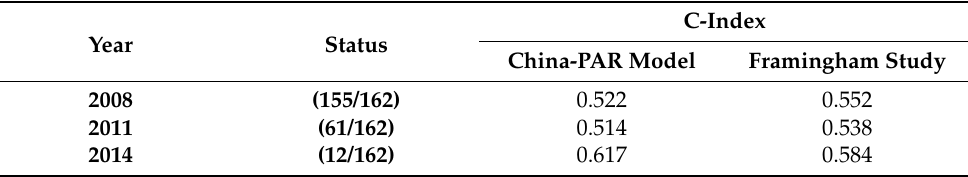
Table 6. Table of C-index results based on China-PAR model and Framingham study, implemented on our dataset (number of stroke individual/number of no stroke